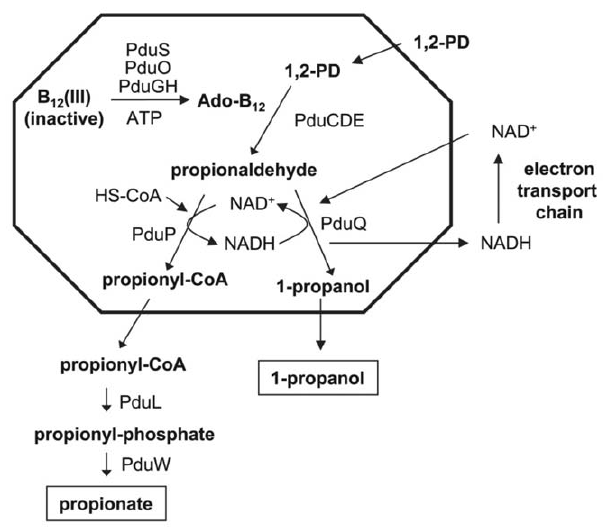
Figure 1. Model for the Pdu microcompartment and the role of PduQ. The Pdu MCP consists of a protein shell that encapsulates enzymes and cofactors for metabolizing 1,2-propanediol. The shell is thought to be made from 9 proteins (PduABB’JKMNTU). Encapsulated within are enzymes for the activation of B 12 (III) to coenzyme B 12 (Ado- B